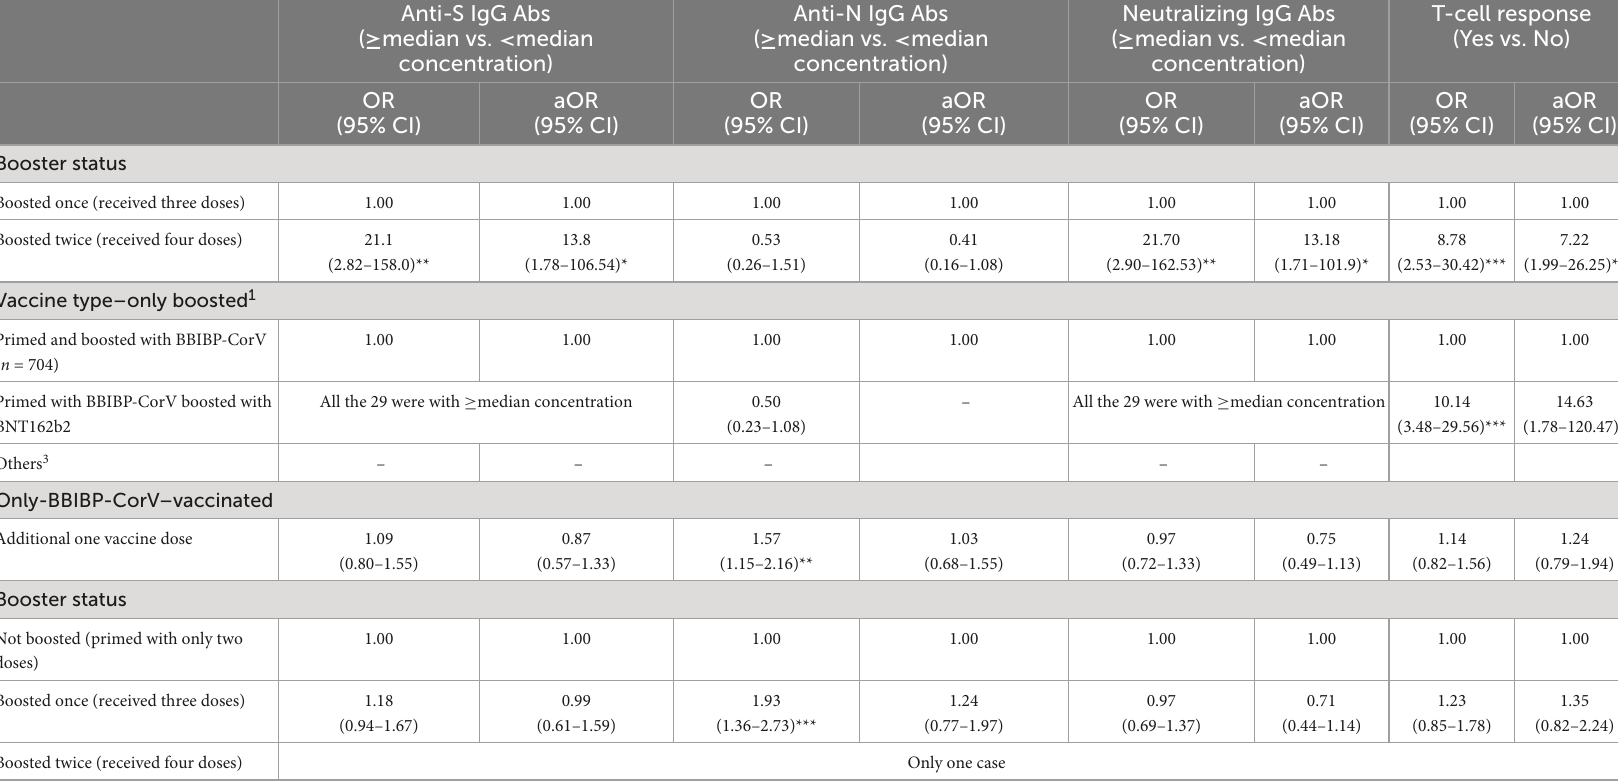
TABLE 6 Crude (OR) and adjusted odds ratio (aOR) of the association between every dose increase in the number of anti-SARS-CoV-2 vaccine doses and boosting status with having ≥ median concentration of anti-S IgG ( ≥ 357.5 BAU/ml), anti-N IgG ( ≥ 146.5 COI), and neutralizing IgG ( ≥ 172.0 AU/ml) antibodies and having a T-cell